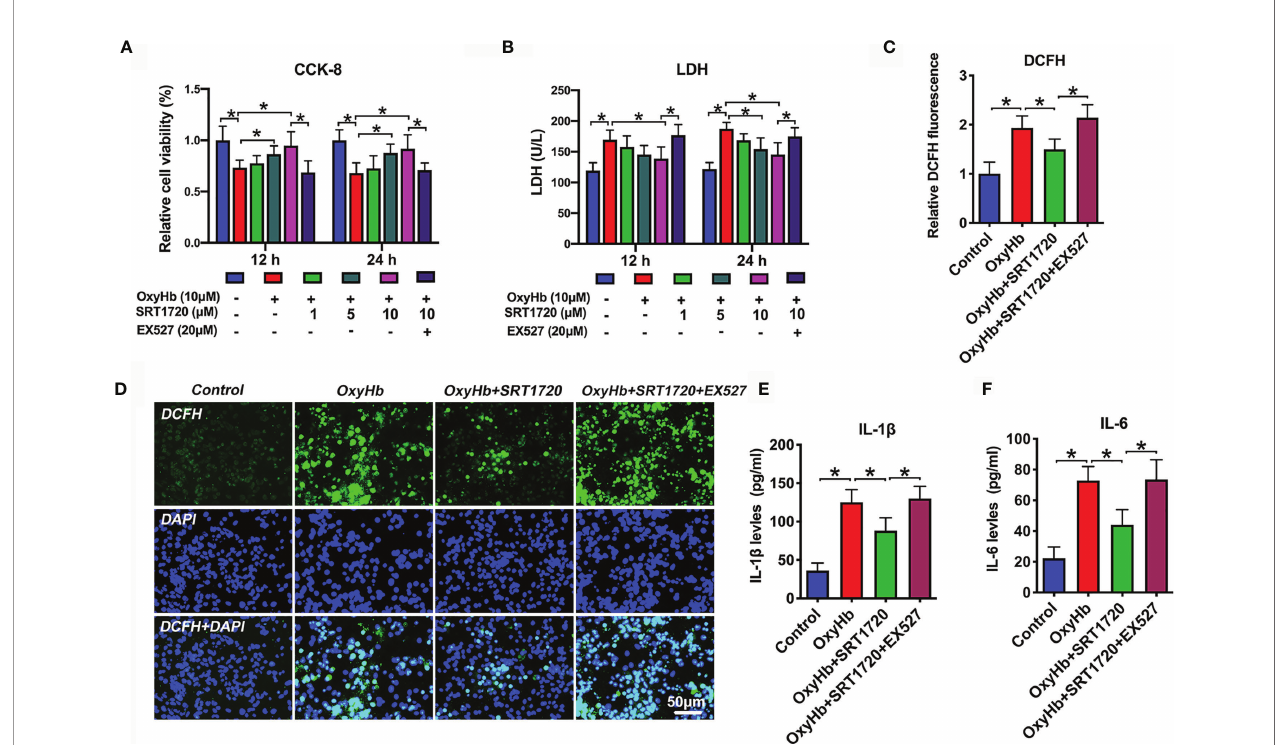
FIGURE 8 | Effects of SRT1720 treatment on oxidative stress, in fl ammatory response, and neuronal damage in vitro . Quantitative analysis of CCK-8 (A) and LDH activity (B) in the indicated groups. Quanti fi cation (C) and representative photomicrographs (D) of DCFH immuno fl uorescence in primary cortical neurons. Quantitative analysis of IL-1 b (E) , and IL-6 (F) in the indicated groups. Bars represent the mean ± SD. * P <